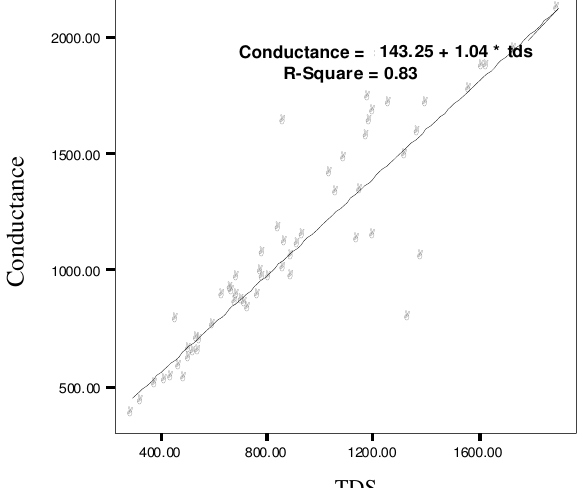
Figure 2. Correlation between total and dissolved solids (TDS and